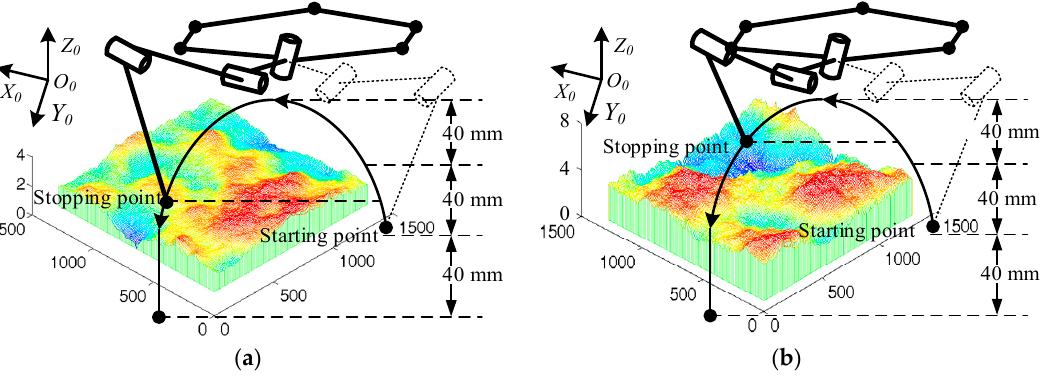
Figure 6. Two diagrams of autonomous terrain identification strategy: ( a ) Identification of light rough terrain and ( b ) identification of high rough terrain.